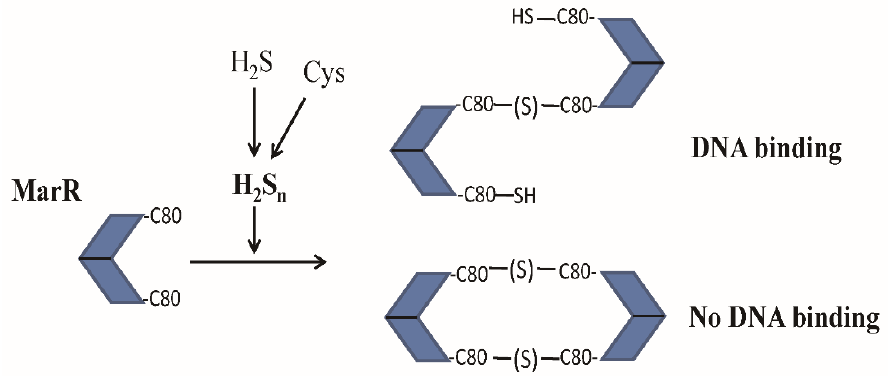
Figure 5. Schematic representation of MarR, which senses sulfane sulfur, forming disulfide and trisulfide crosslinks between Cys 80 . A mixture of tetramer with one and two disulfide bonds may coexist after H 2 S n treatment. The tetramer with two disulfide bonds does not bind to its target DNA [30], but our results suggest that the tetramer with one disulfide bond does bind to its target DNA. MarR family proteins are small proteins with a winged helix–turn–helix (wHTH)